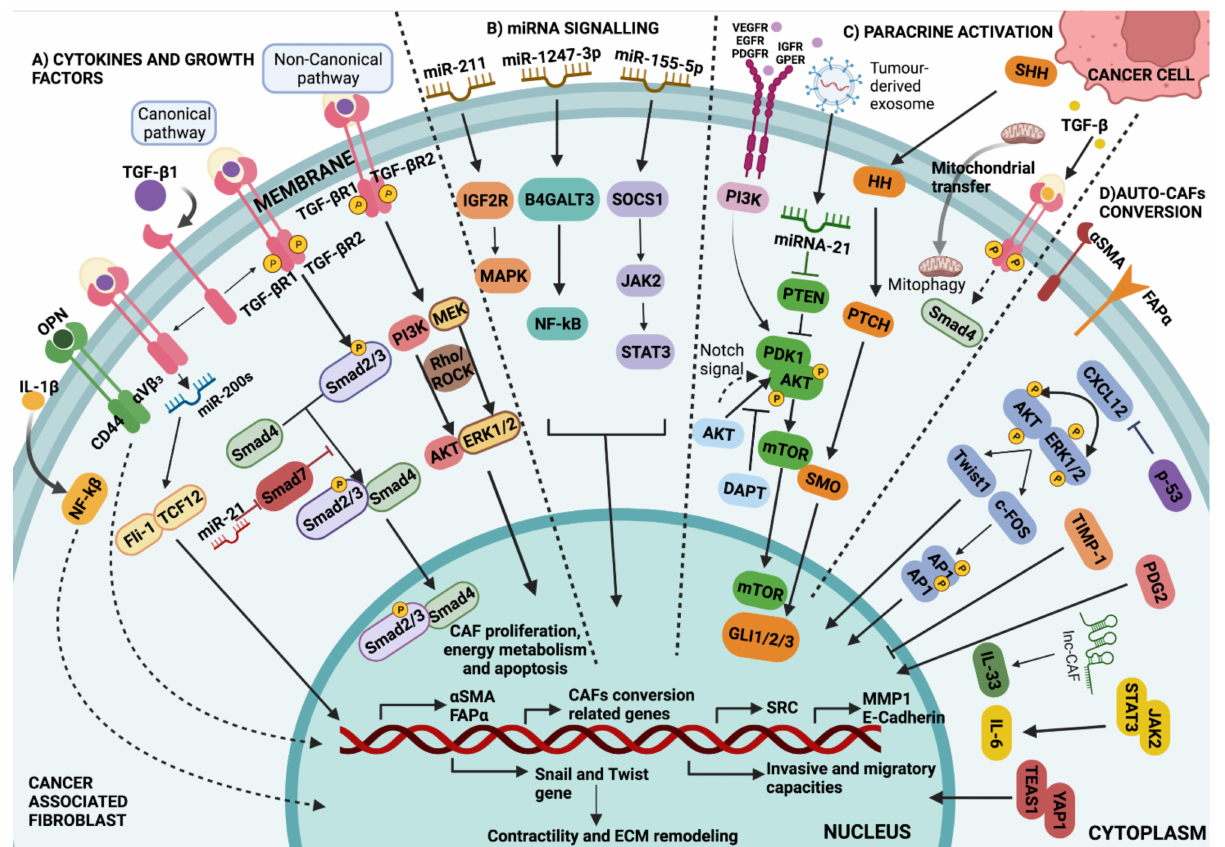
Figure 2. Major pathways involved in CAF development. ( A ) Cytokines and growth factors: Regu- lation of CAF-specific gene expression through TGF- β signalling via Smad-dependent and Smad- independent pathways. In the canonical pathway, Smad2/3-Smad4 translocate to the nucleus and bind to a specific DNA sequence, being possibly inhibited by Smad7. In the non-canonical pathway, TGF- β promotes the activation of several signalling pathways, other than Smad, including PI3K ki- nases, MEK, and Rho-Rock, among others. ( B ) miRNAs signalling: miRNAs and lncRNAs transform NAFs into CAFs through downstream signalling involving JAK/STAT, NF- κβ , and MAPK cascades. ( C ) Paracrine activation: Through the PDK1/AKT signalling pathway, in which tumour exosome miRNA-21 inhibits it and PI3K promotes it. Notch signalling via AKT signalling pathway controls AKT phosphorylation and mTOR activation. As a result, mTOR regulates the expression of targeted genes associated with differentiation into CAFs; in addition, expression of tumour cell-derived SHH has been confirmed to modulate CAFs via paracrine activation of HH signalling, and the overexpres- sion of SMO in CAFs contributes to HH signal transduction and GLI1 activation. Fibroblasts can also be metabolically reprogrammed via cancer cell-derived mitochondrial transfer and the TGF- β sig- nalling pathway derived from cancer cells. ( D ) Auto CAFs-conversion: A self-propelled conversion induced by changes in cellular homeostasis, which controls the activation of cytoskeletal proteins and the secretory phenotype via the YAP1/TEAS1 and JAK2/STAT3 signalling pathways. EMT is facilitated by an activated CXCL12 signal via the ERK/AKT-Twist1-MMP1 pathway. TIMP-1 is related to collagen contractility and CAF proliferation and migration through the ERK1/2 signalling pathway in CAFs (Table